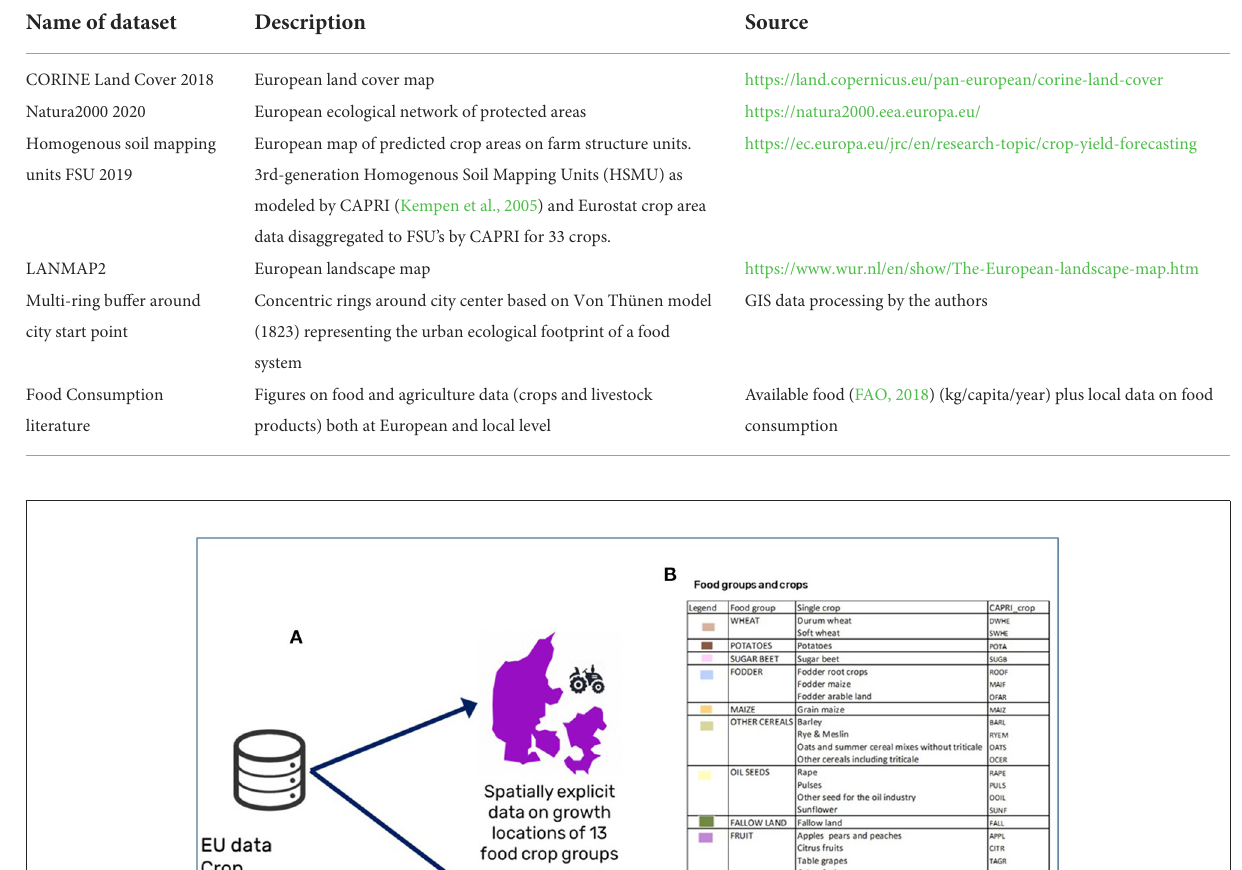
TABLE 1 Datasets utilized in MFP.